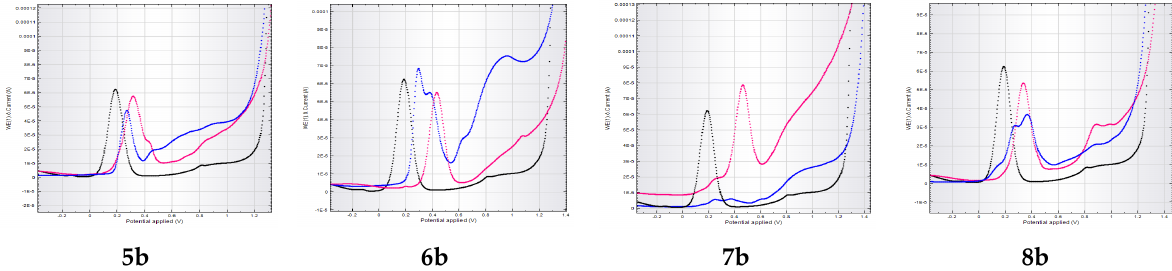
Figure A11. Overlapped DPVs for the oxidation signal obtained for 0.5 mM of the novel synthesized compounds (blue); 2 mM TEMPO (black) and after one hour incubation with 0.5 mM of the novel synthesized compounds (pink) on graphite- based SPE. Solutions were prepared in 0.1 M HClO 4 .